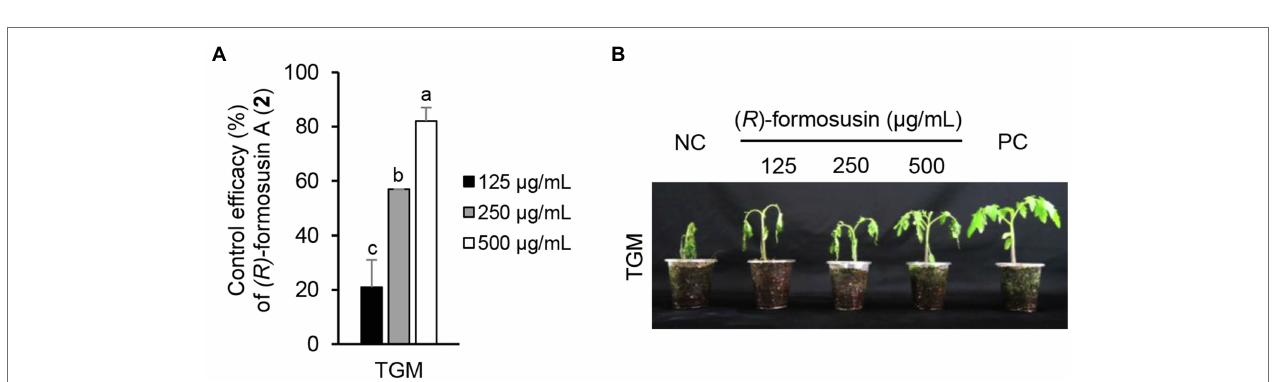
FIGURE 5 | Effect of ( R )-formosusin ( 2 ) isolated from Aspergillus candidus SFC20200425-M11 on the development of tomato gray mold (TGM) caused by Botrytis cinerea . (A) Control efficacy of ( R )-formosusin ( 2 ) against TGM. The bars represent the mean ± standard deviation of two runs with three replicates. Different small letters in each bar indicate a significant difference at p < 0.05 (Duncan’s multiple range test). (B) Representatives of plants treated with ( R )-formosusin ( 2 ) at a concentration of 125, 250, and 500 μ g/ml. Plants were inoculated with spores of B. cinerea 1 day after treatment with ( R )-formosusin ( 2 ). Treatment with the Tween 20 solution containing 5% methanol and a chemical fungicide (fenhexamide) were prepared as negative and positive controls (NC and PC),